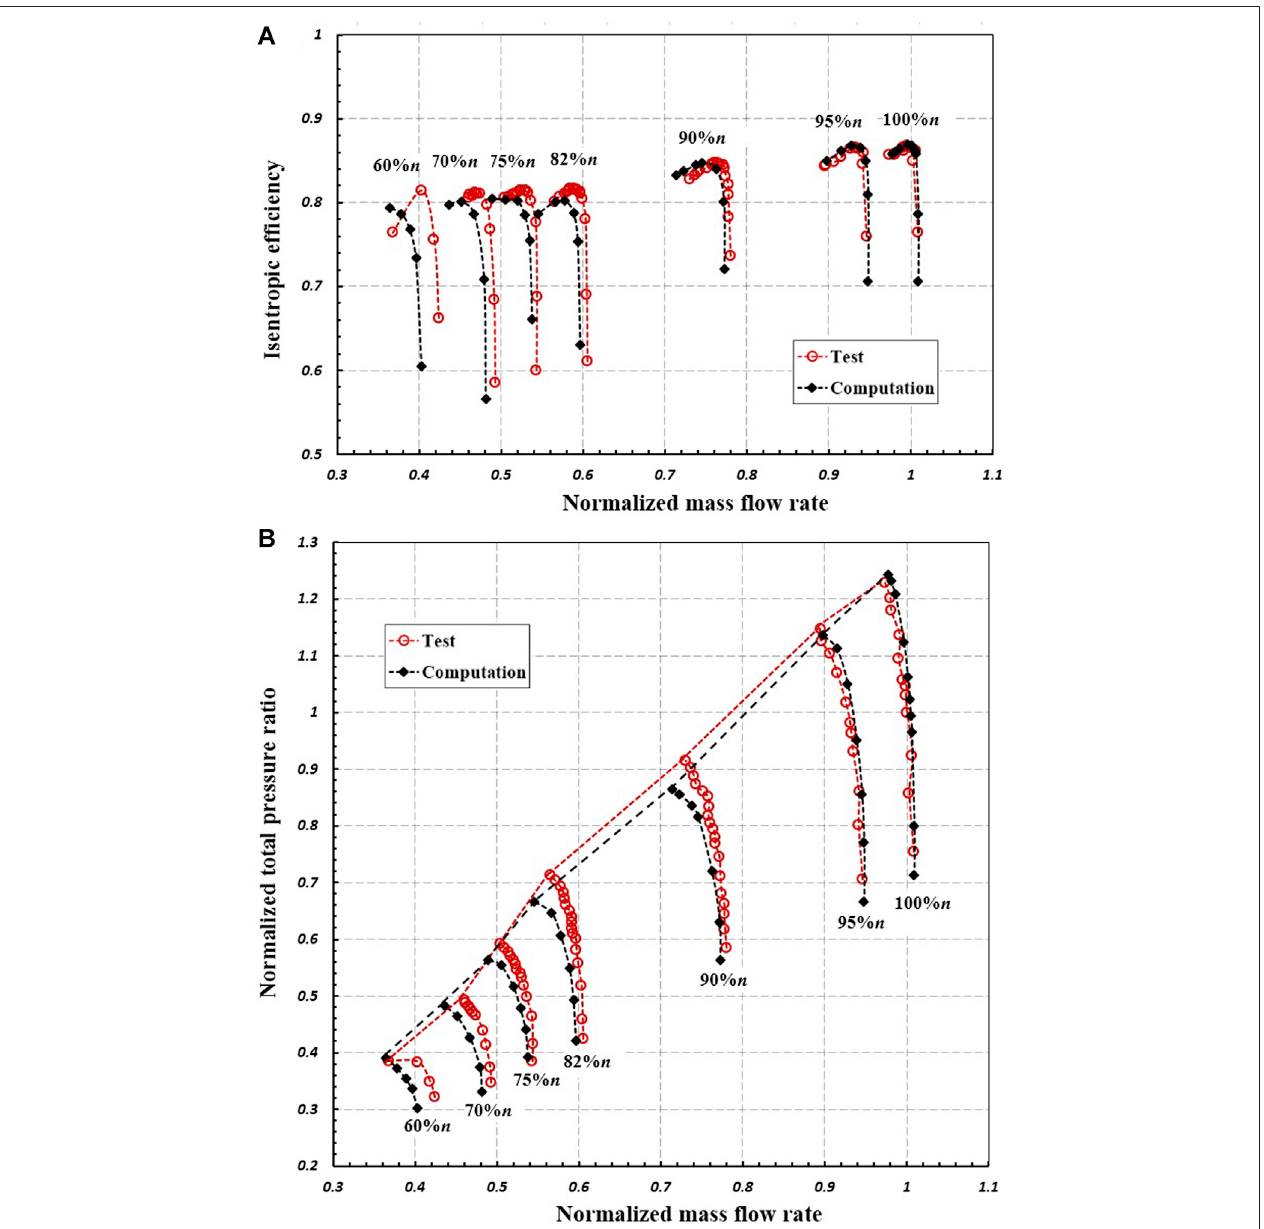
FIGURE5| Comparison ofcharacteristiccurvesforthecompressor performancebetweencomputationandtest. Characteristicsofisentropicef fi ciencyrelativeto normalized mass fl ow rate (A) , Characteristics of normalized total pressure ratio relative to normalized mass fl ow rate (B) .